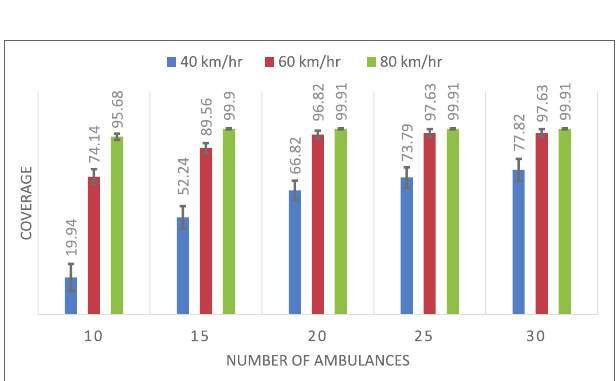
FigUre 7 | Mean and SD of the coverage using double standard model.